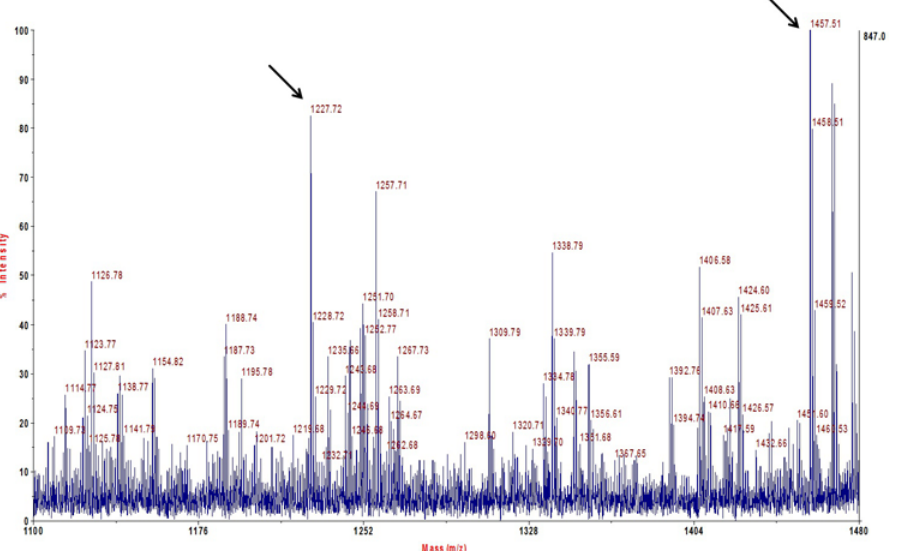
Fig 2. MALDI-TOF mass spectrum of the trypsin-digested ~26 kDa gel band recognized by mAb Tc6/ 42.6.4. The peak at 1227.72 m/z corresponds to the peptide VLQMHELTTR and the peak at 1457.51 m/z corresponds to the peptide LSFNEVCSGCER (with two